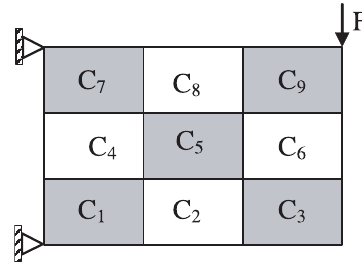
Fig. 1. Principle of adjacency